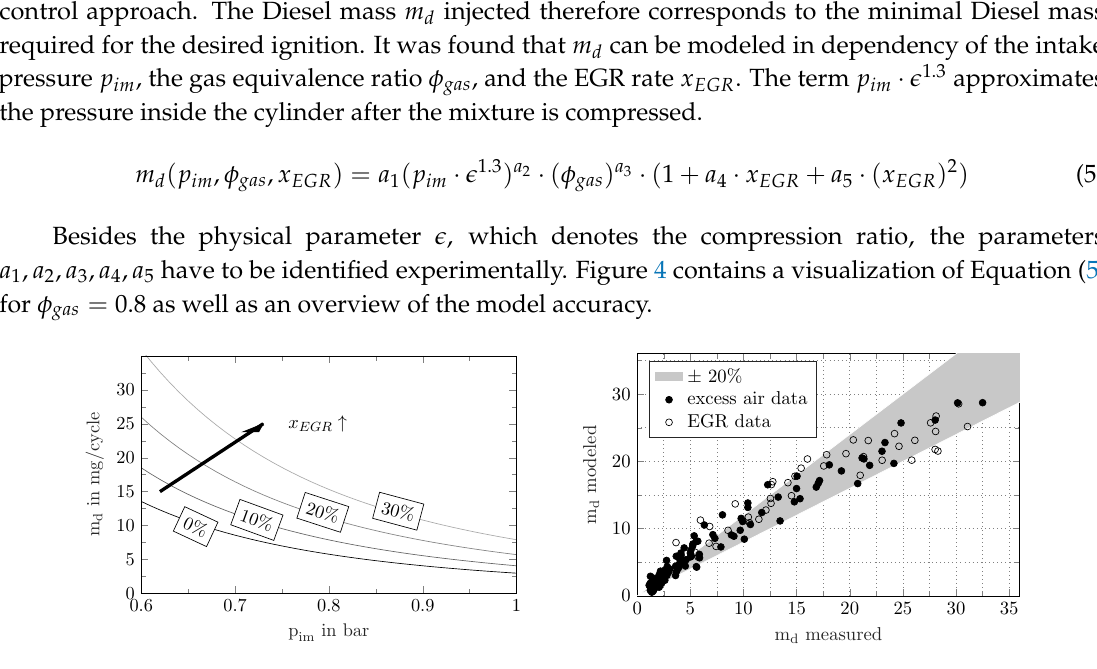
Figure 4. ( Left ) Relation of Diesel mass m d , intake pressure p im , and EGR ratio x EGR according to Equation (5) with φ gas = 0.8; ( Right ) Comparison of model and measurement data with dilution with excess air and